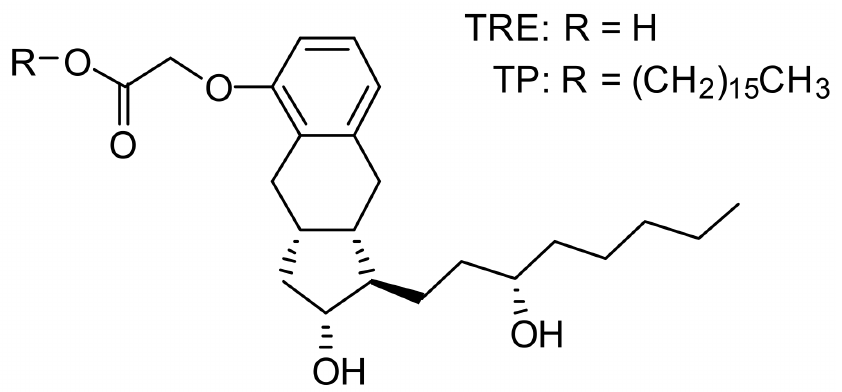
Figure 1. Chemical structure of treprostinil (TRE) and treprostinil palmitil